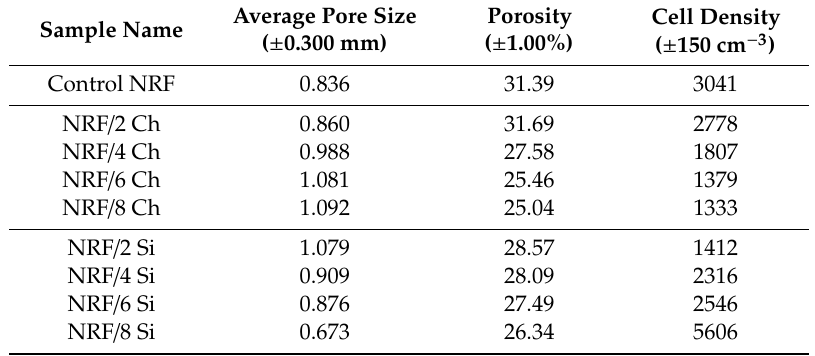
Table 2. Average pore size, porosity, and cell density of the control NRF and NRF with filler